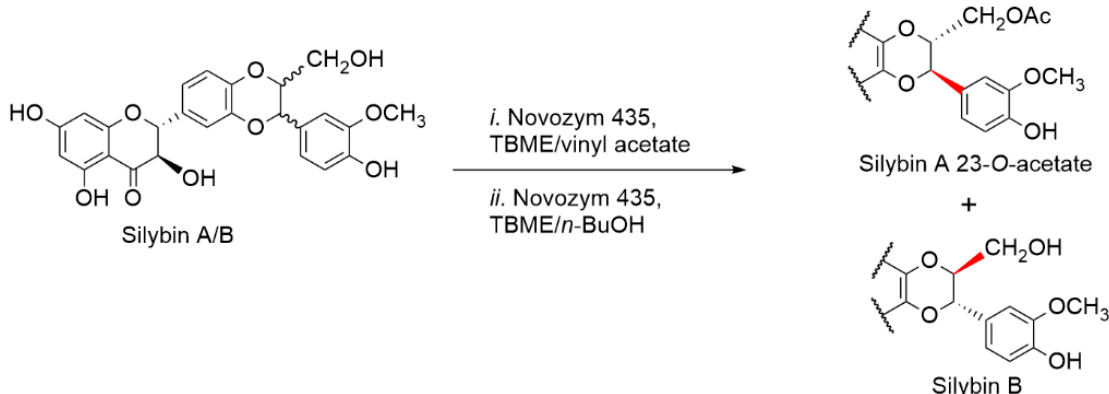
Figure 3. Chiral separation of natural silybin with immobilized lipase B from C. antarctica (Novozym ® 435), TBME— tert - butyl methyl ether. Silybin B and silybin A 23- O -acetate are separated by conventional flash chromatography; while pure silybin B is obtained directly, silybin A is then deacetylated with Novozym ® 435 under hydrolytic conditions [58].